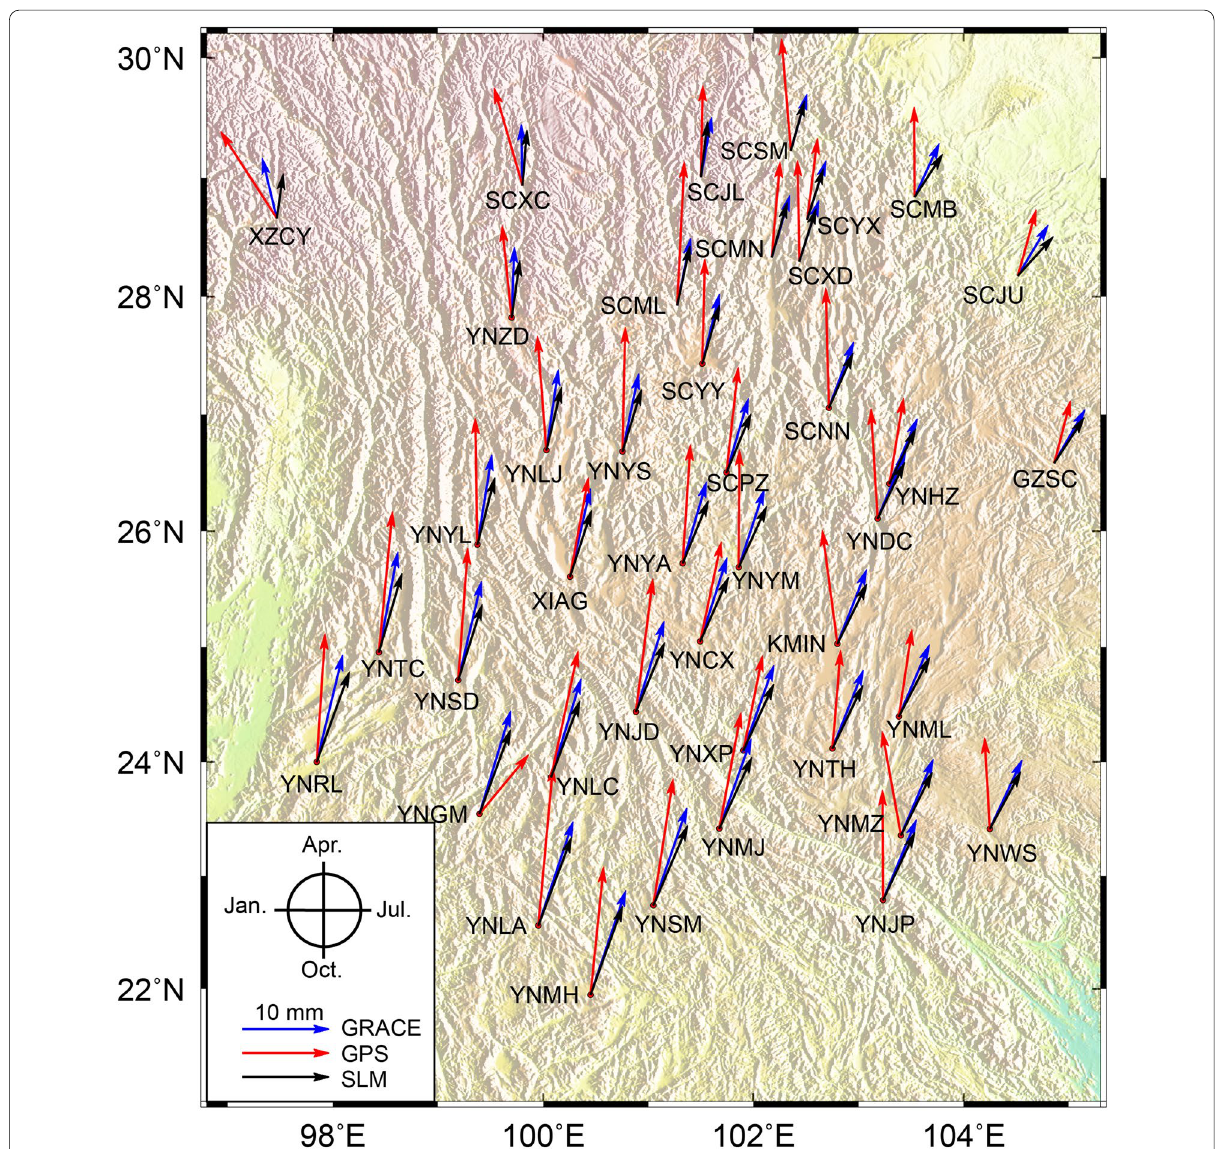
Fig. 7 Amplitudes and phase of total loading deformation estimated by global positioning system (GPS) stations, gravity recovery and climate experiment (GRACE), and surface loading model (SLM) at 41